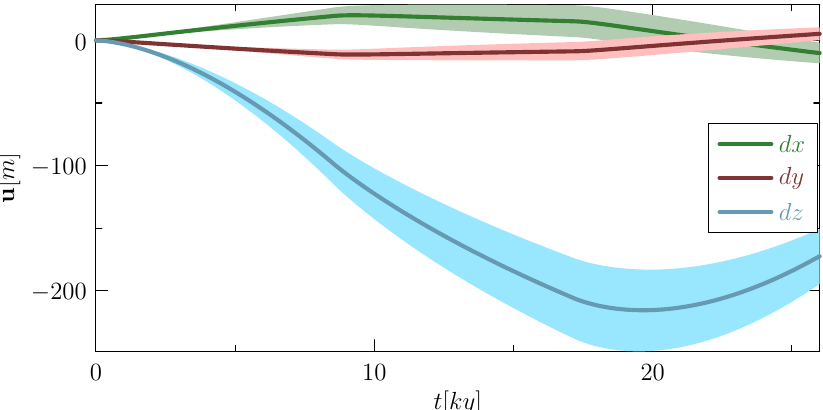
Figure 4. A zoom of the computational cells on the crust layer of the glacial rebound simulations. The magnitude of the vertical displacement is shown (meters). The black edges highlight the computational cell used to calculate the deformation gradient F .